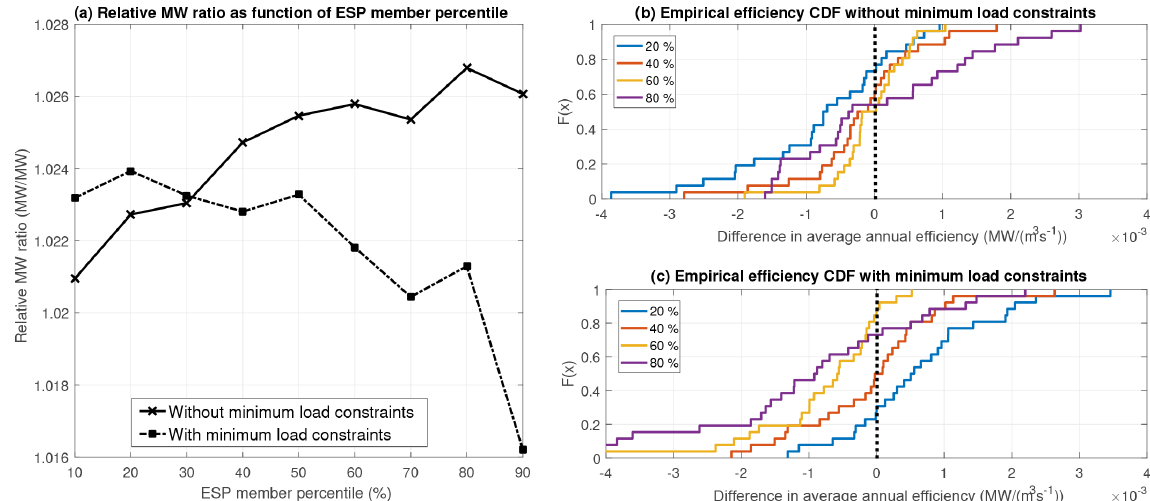
Figure 6. Average energy generation of the entire system with varying levels of ESP forecast bias when the decision linked to the optimization of the median inflow scenario is used to derive the water drawdown policy. Panel (a) shows the relative MW ratio with and without MLCs, whereas panels (b) and (c) show the difference in average annual efficiency for a subset of selected percentiles compared to the median percentile without and with MLCs respectively.